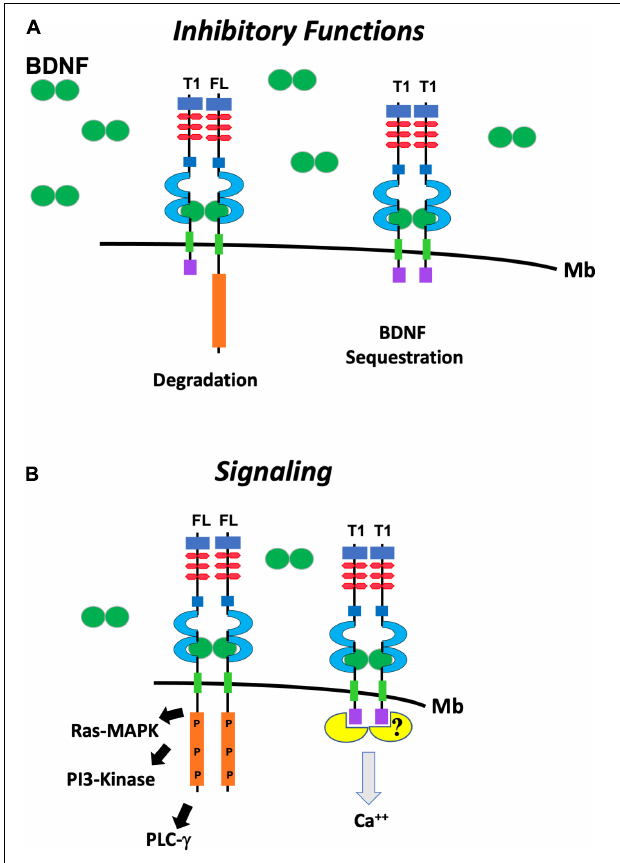
FIGURE 2 | Schematic representation of the putative functions of TrkB.FL (FL) and TrkB.T1 (T1). (A) TrkB.T1 has inhibitory functions when it heterodimerizes with one isoform of TrkB.FL in response to BDNF (green ovals) binding and leading to internalization and degradation of the heterodimer (left). It also inhibits BDNF signaling by binding and sequestering it when it homodimerizes (right). (B) TrkB.FL (FL) homodimers in response to BDNF signal lead to auto-phosphorylation the kinase domain (P) and activation of the Ras/MAP Kinase (Ras-MAPK) pathway, phosphoinositide 3 kinase (PI3-Kinase) and phospholipase C γ (PLC γ ) pathways (left). TrkB.T1 homodimers can induce calcium (Ca++) release from the intracellular store through the binding and activation of a still unknown pathway